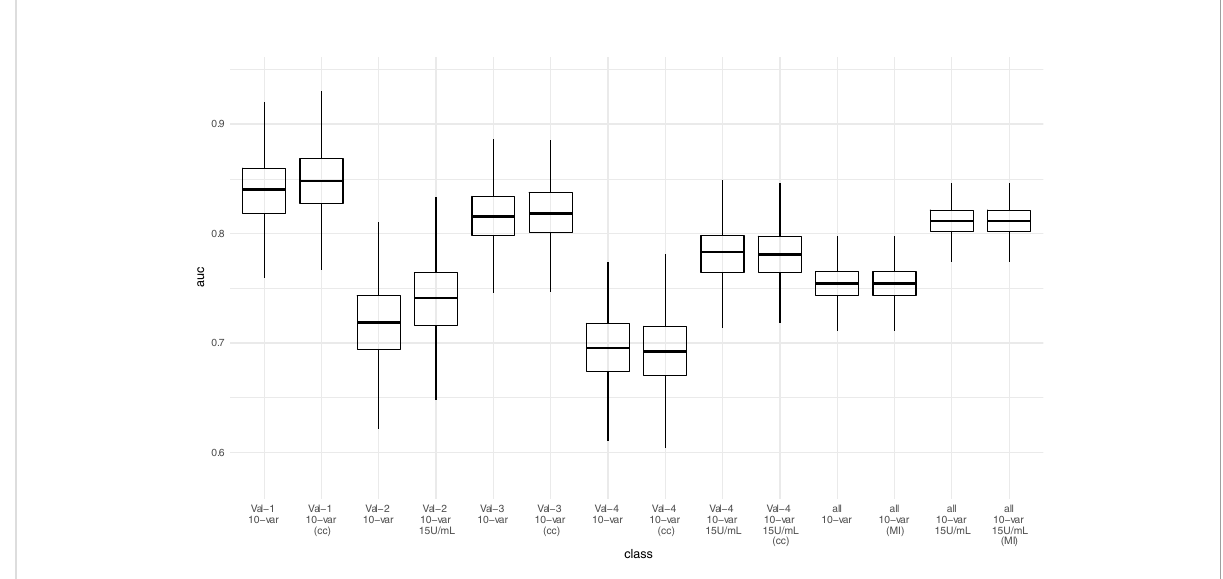
FIGURE 4 Predictive performance (AUC-ROC) of the 10-variable model in external validation. Each point represents the AUC-ROC in 1 out of 1000 bootstrap samples. Horizontal lines within the box depict the median and the upper and lower horizontal lines depict upper and lower quartiles, respectively. To assess the impact of the mean/median imputation method chosen, we also provide model performance when performing complete case analysis (cc) for validation sets 1, 3, and 4. For validation set 2, due to missing variable “ Dialysis years ” for all patients, no complete case analysis could be performed. Additionally, we performed multiple imputation (MI) in the pooled validation datasets (all) and assessed model performance here as well. Val – Validation cohort, 10-var – 10-variable model, all – all validation sets pooled, cc – complete case analysis, MI – multiple